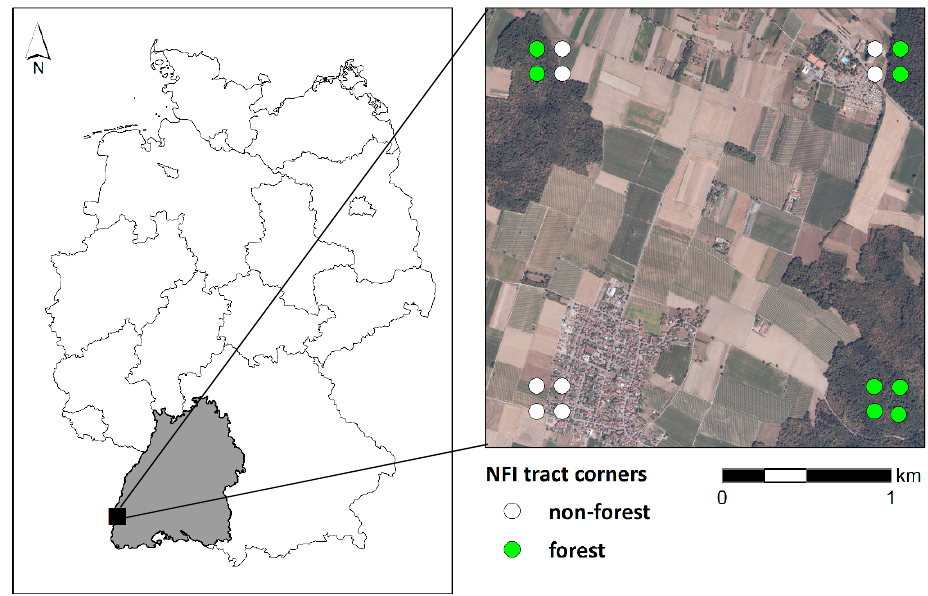
Figure 3. In Baden-Württemberg, the NFI tracts are aligned on a systematic, national sampling grid of 2 × 2 km. For each NFI tract corner, the presence/absence of forest is recorded (“forest decision”). To analyze forest cover within an NFI plot, the NFI tract corners were buffered with a radius of 10 m. This corresponds to the median distance between the NFI plot center and the maximum measured distance of all corresponding sample trees. The authors of [54] considered this approach as reasonable. In a further step, the percentage of forest cover within each plot was calculated. Since forest cover layer refers to land cover and NFI data to land use, the NFI data were filtered based on the available NFI plot information. For this purpose, only those NFI plots which were located in a